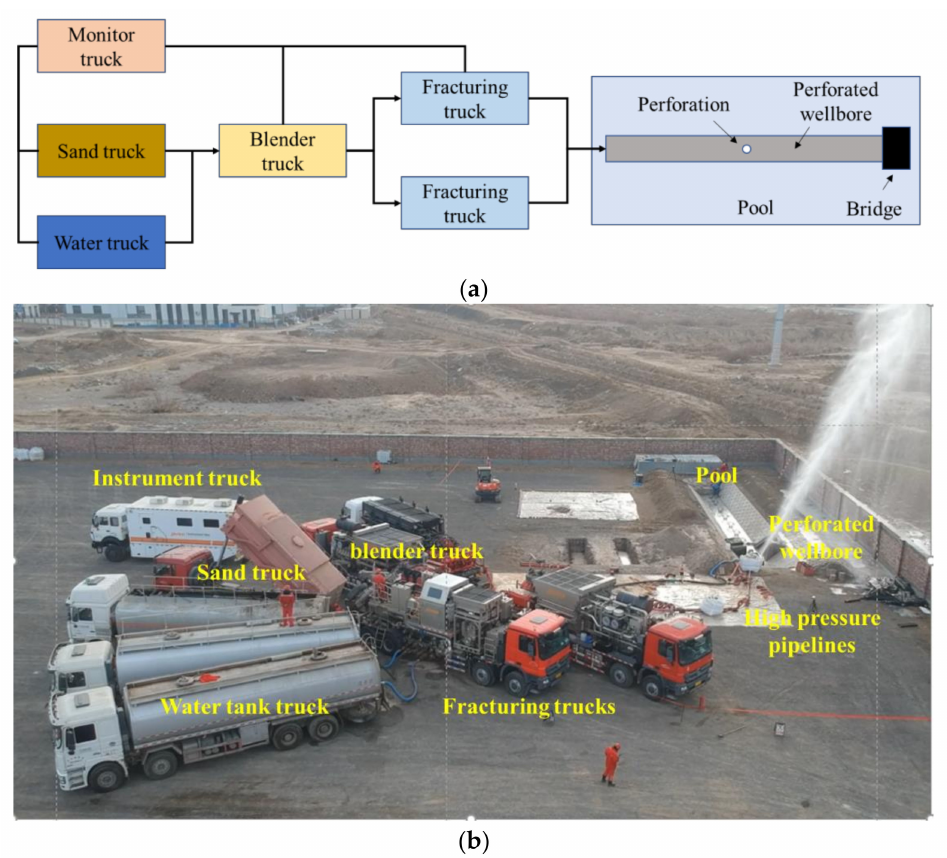
Figure 2. Real field-scale perforation erosion evaluation system ( a ). Schematic diagram, ( b ). Physical model.